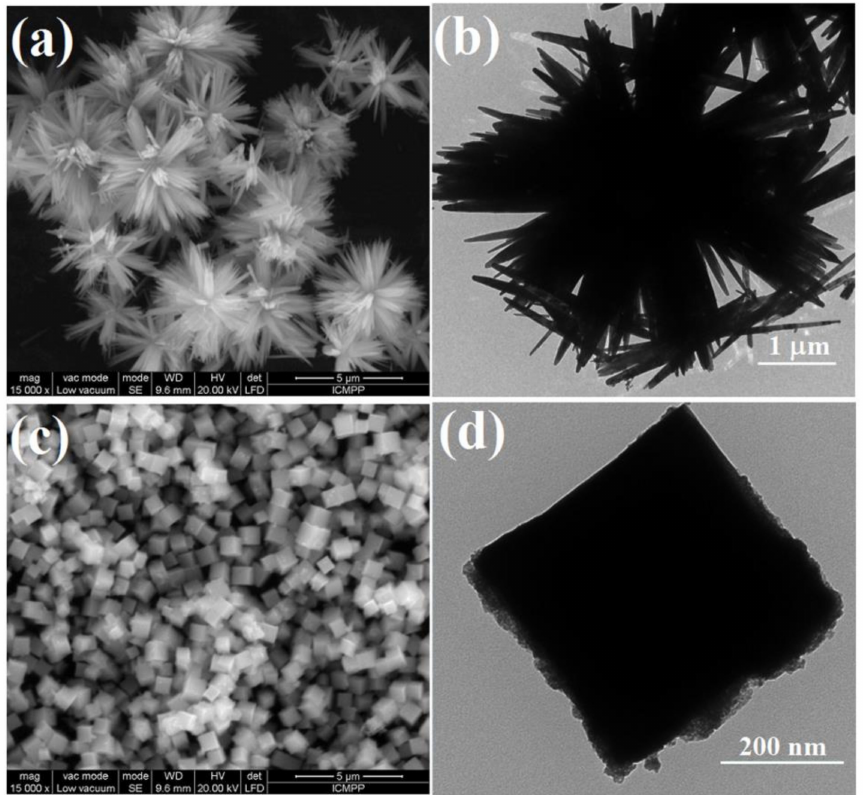
Figure 3. SEM and TEM images of ZnO ( a , b ) and ZnO-SnO 2 ( c , d